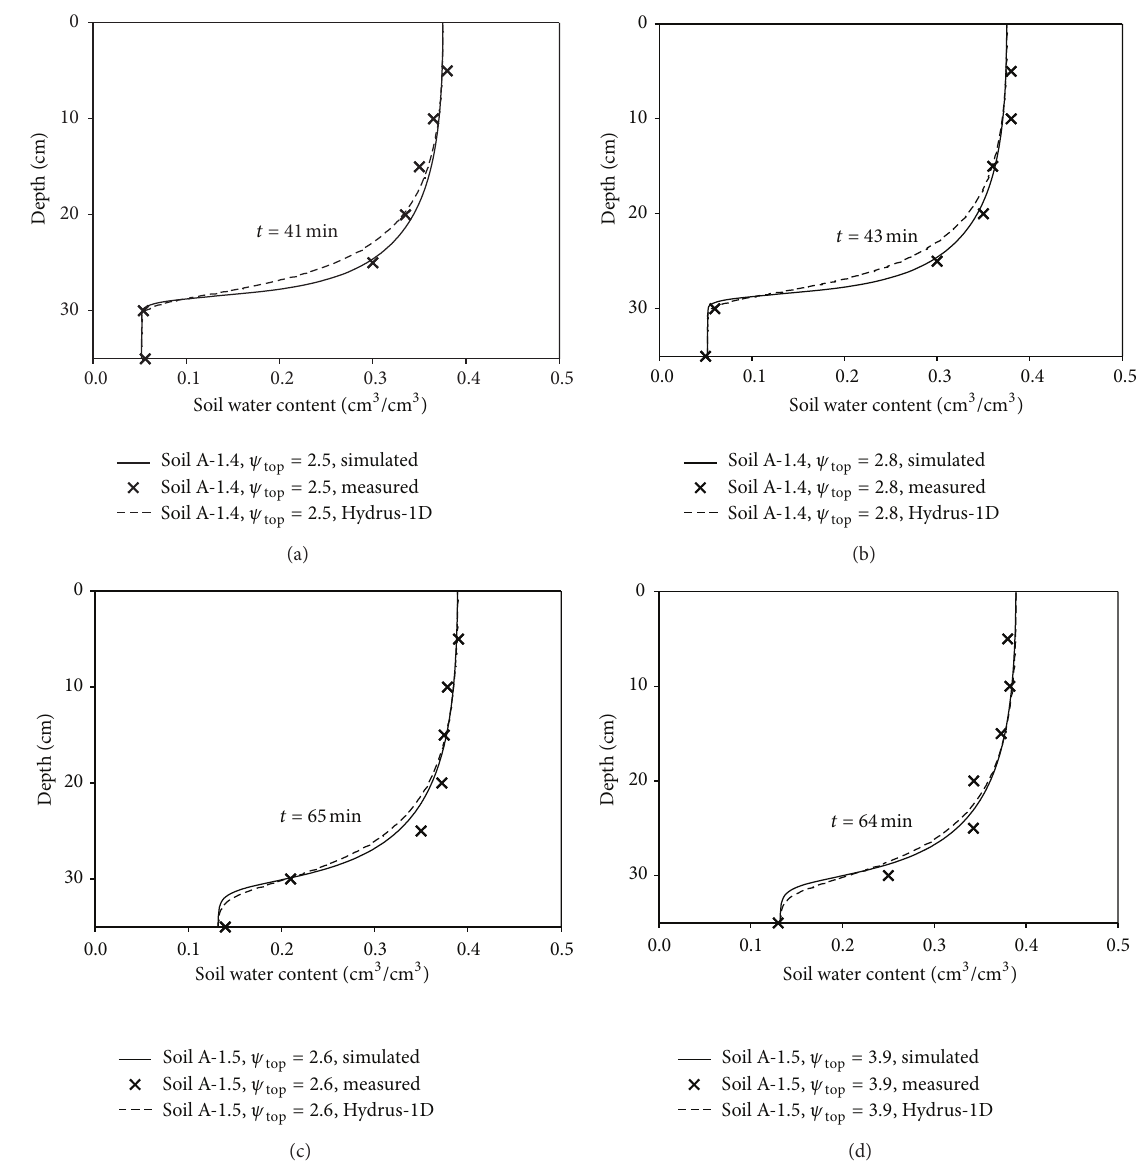
Figure 3: Comparison of the model simulations of the soil water retention curve with measured data and the Hydrus-1D simulation for columns of Soil A packed to two different bulk densities (1.4 or 1.5g/cm 3 ) for various ponded depths (𝜓